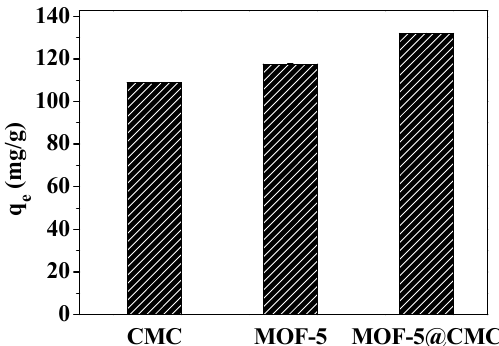
Figure 13. Pb(II) adsorption capacities of the adsorption materials in this study.